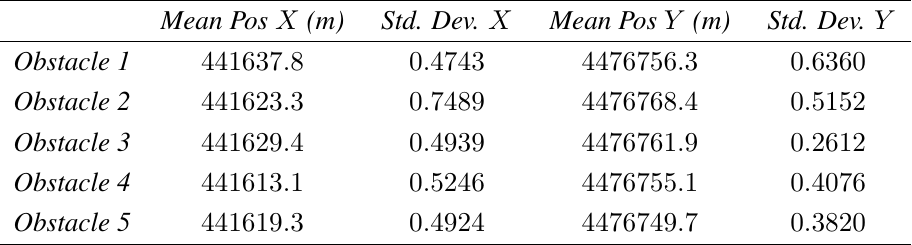
Table 2. Mean Value and Standard Deviation for all the obstacles found in the Test